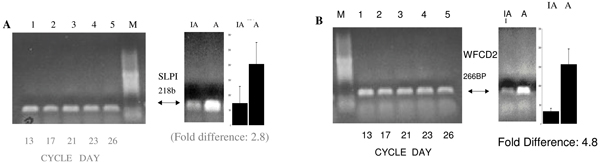
Semiquantitative PCR analysis comparing Inadequate (IA) and Adequate (A) cDNA populations on cycle days 13, 17, 21, 23, and 26 for SLPI and WFDC2 (panels A and B respectively) [66]. Lane M is a size marker (100 bp DNA ladder). The side panels compare IA and A cDNA populations on day 23 (midsecretory phase) for each gene and the column charts represent average densitometric analysis of three experiments and margin of error (SD).